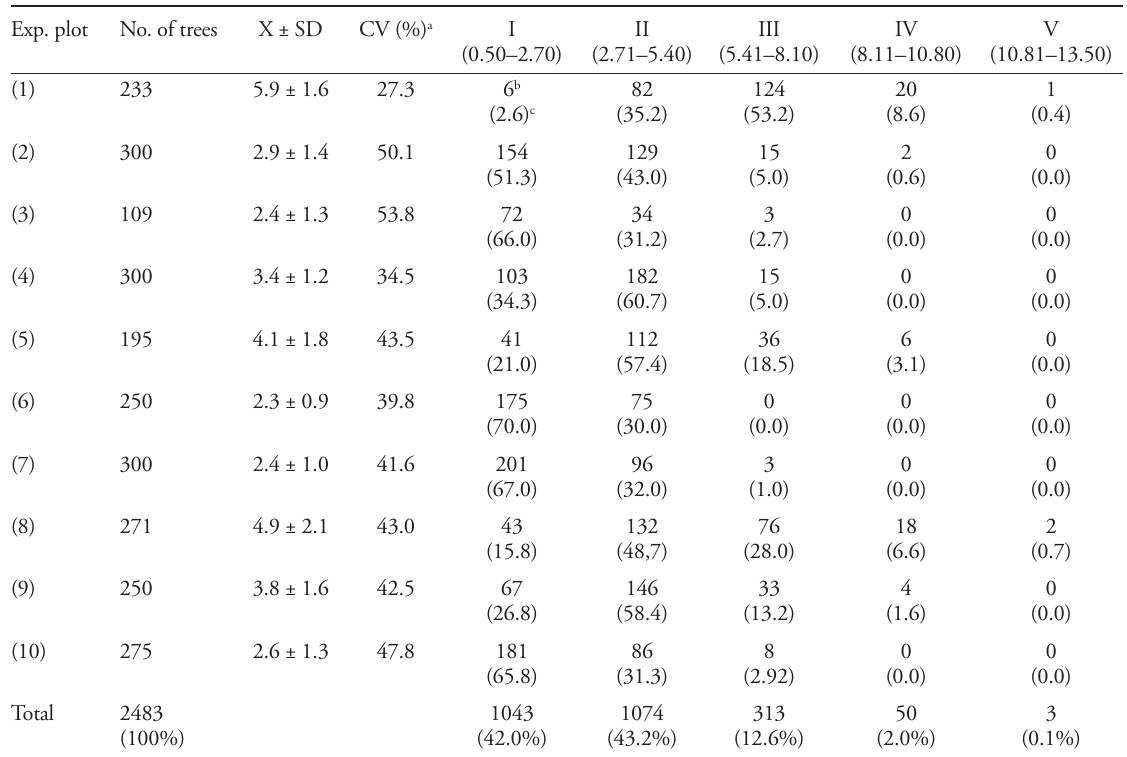
Table 4. Mean resin production and classification of experimental trees into five resin production classes. Production of class I–V is given in kg within brackets. a CV = coefficient of variation, b no. of trees, c percentage of recorded trees. Exp.